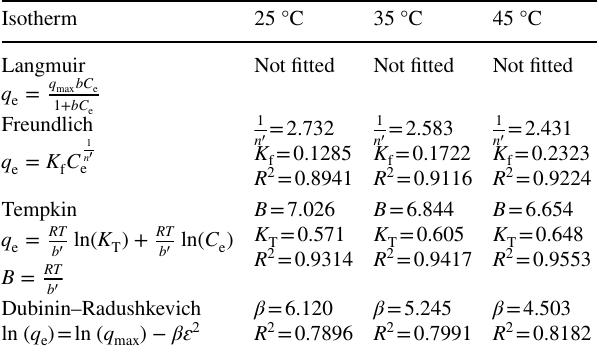
Table 1 Values of different isotherm constants